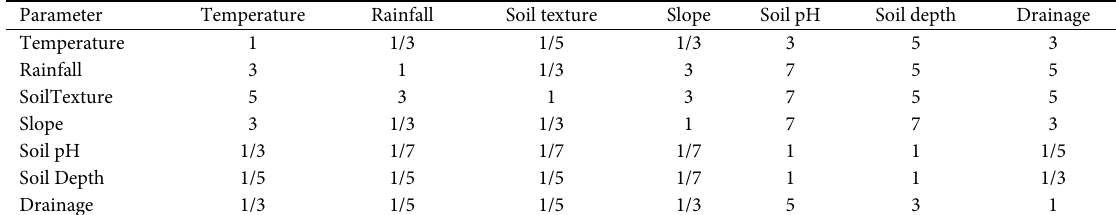
Table 3: Pairwise comparison matrix